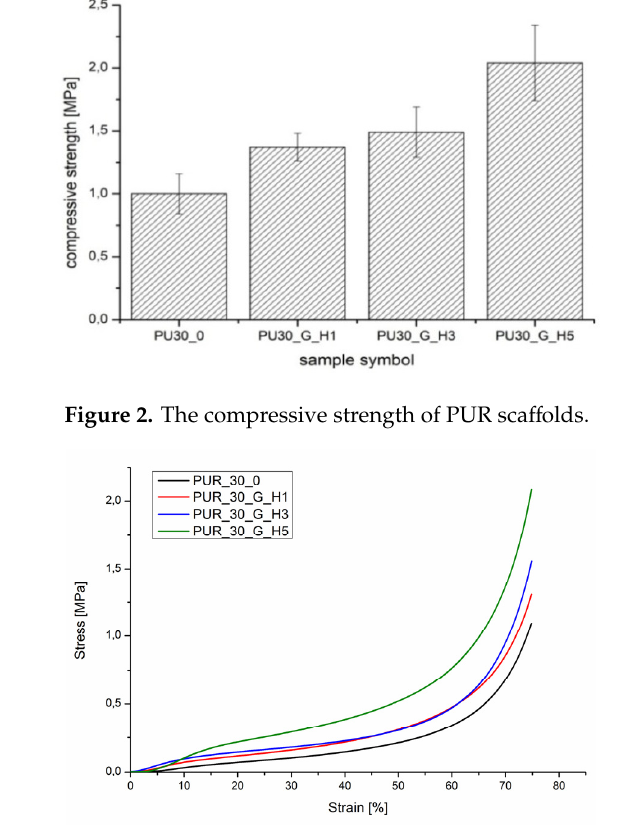
Figure 4. The strain directly after compression and after 24 h of PUR scaffolds.